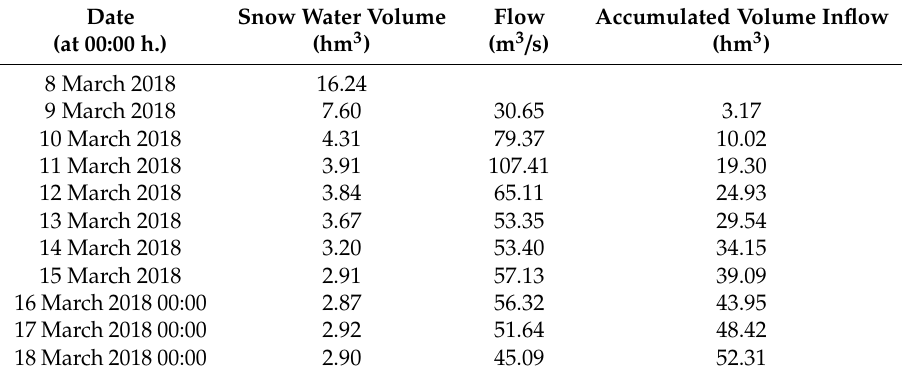
Table 3. Expected values of average daily flows, entering the El Burguillo reservoir from AEMET (most probable) temperature and rainfall predictions.